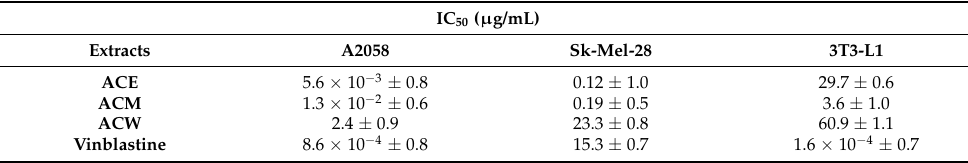
Table 4. IC 50 values of ethanolic, methanolic and aqueous Annona cherimola Mill. leaf extracts (ACE, ACM and ACW, respectively) expressed in µ